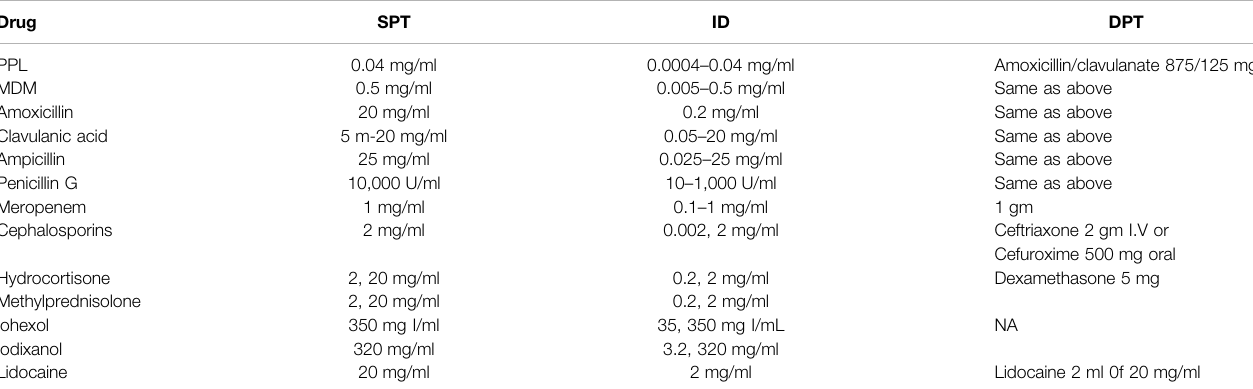
TABLE 1 | Concentrations of the different drugs used for skin prick testing (SPT) and intradermal testing (ID). Drug SPT ID DPT PPL